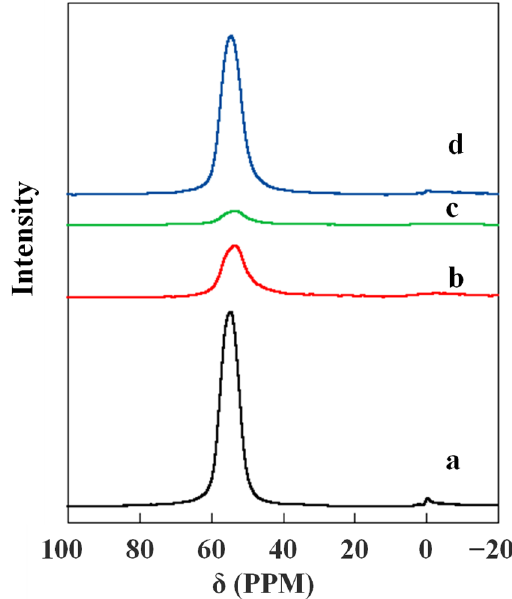
Figure 7. Effects of water on the stability of ETP reactions. Temperature, 500 °C; W/F = 0.0025 g/cm 3 ·min − 1 ; Feed composition: ● (ethylene: N 2 = 1: 2), ■ (ethylene: H 2 O: N 2 = 33: 8: 59), ▲ (ethylene: H 2 O: N 2 = 33: 17: 50), ▼ (ethylene: H 2 O: N 2 = 1: 1: 1), ○ (ethanol: N 2 = 1: 1).